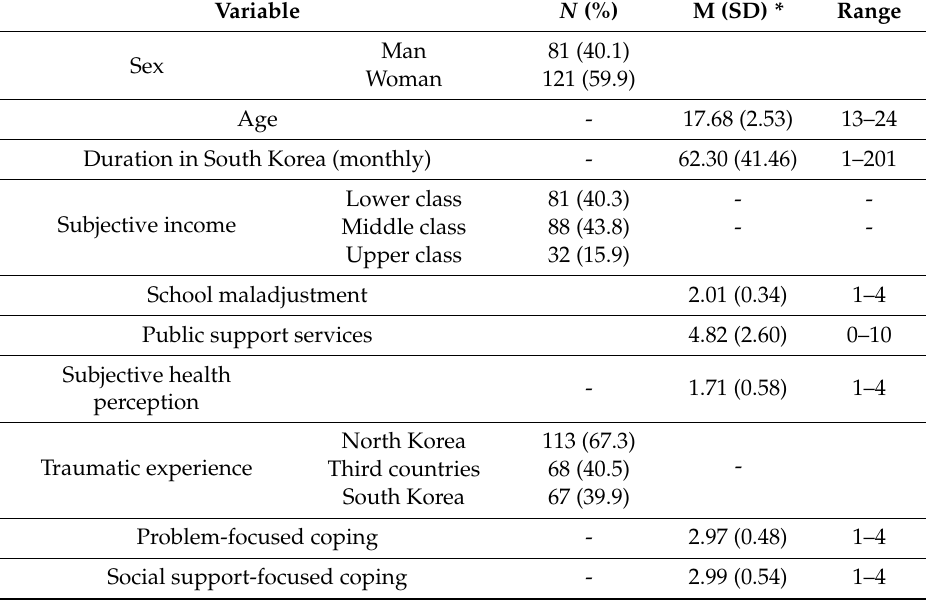
Table 1. Sample characteristics ( N =